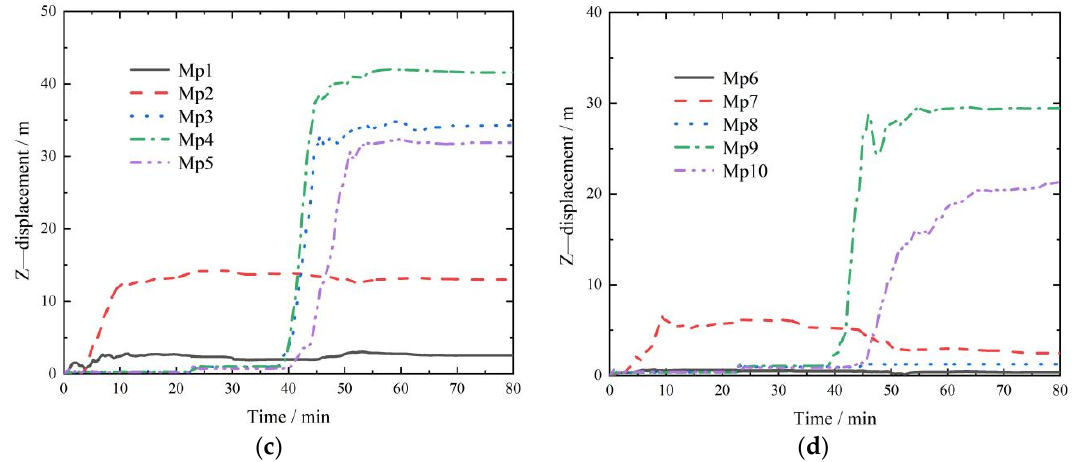
Figure 15. Displacement curves of monitoring points. ( a ) Y-direction horizontal displacement of the slope surface, ( b ) Y-direction horizontal displacement of the deep slope, ( c ) Z-direction horizontal displacement of the slope surface, and ( d ) Z-direction horizontal displacement of the deep slope.